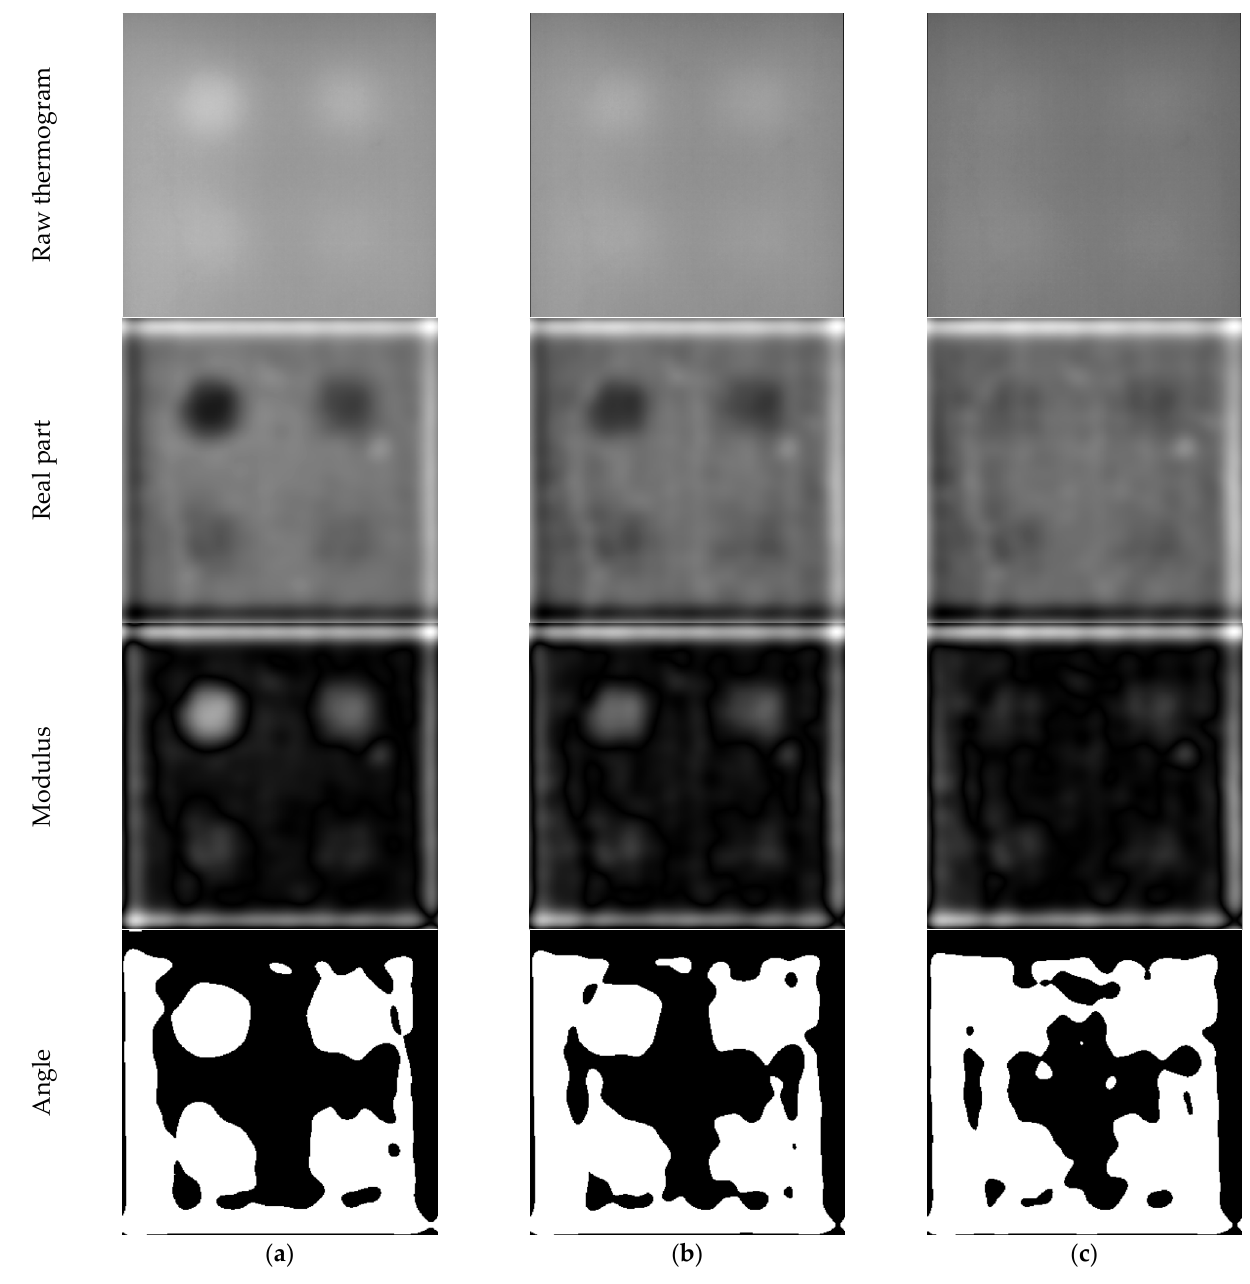
Figure 16. The continuous wavelet transformation results after processing the thermal (grayscale) images, at a scale factor of a = 10. The input images were captured during the cooling stage at the end of ( a ) 7.5 min, ( b ) 15 min, and ( c ) 30 min.